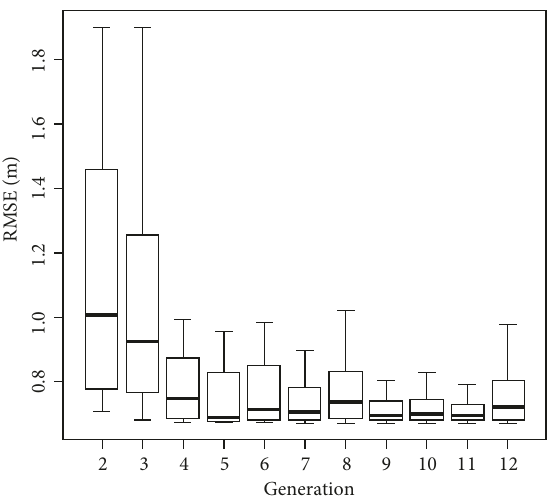
Figure 5: Coevolution convergence of diversity parameters ensemble for metocean